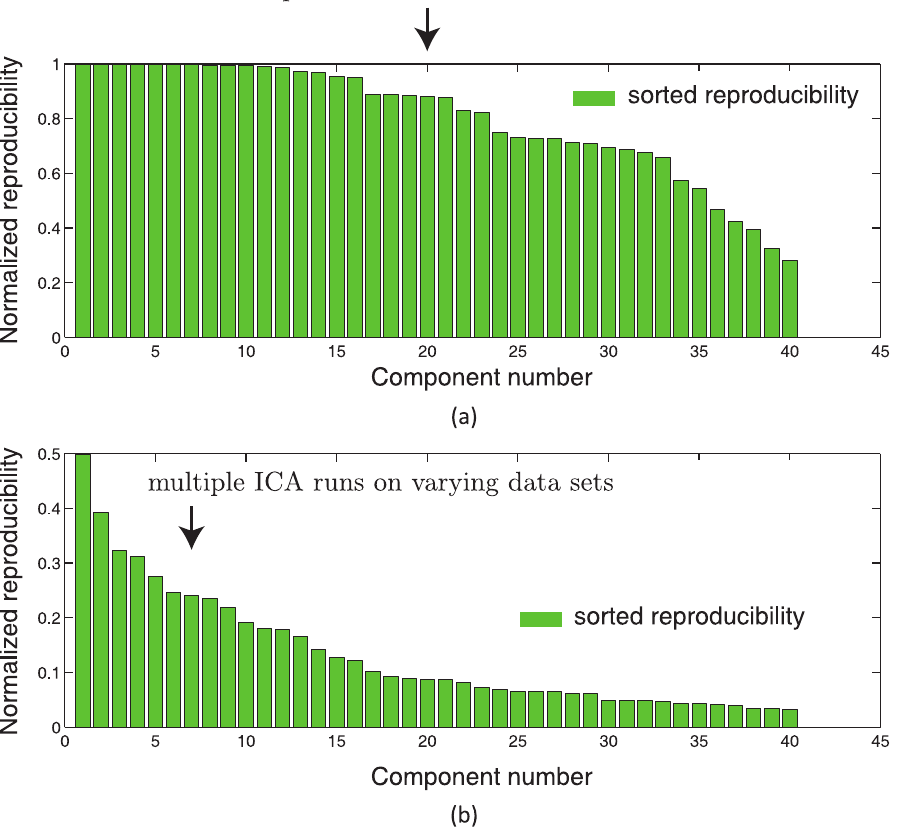
Figure 1. Figure illustrates the variation in normalized reproducibility from RAICAR depending on whether the input to RAICAR is (a) Multiple ICA runs on single subject data or (b) Multiple ICA runs across subjects. Notice that the normalized reproducibility is much lower for across subjects analysis compared to within subject analysis.